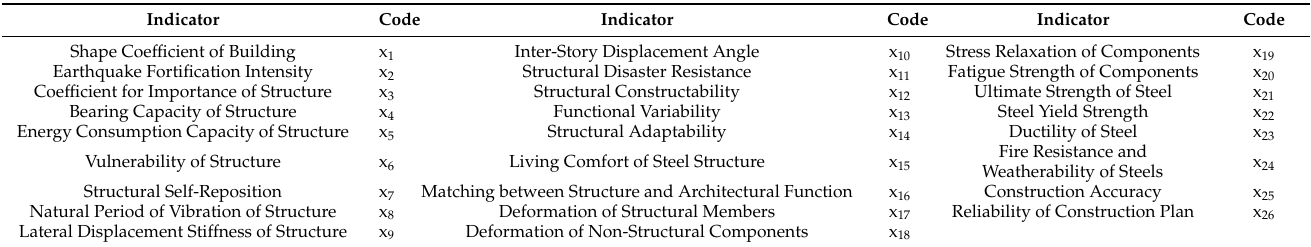
Table 2. The social-technical sustainability indicators.